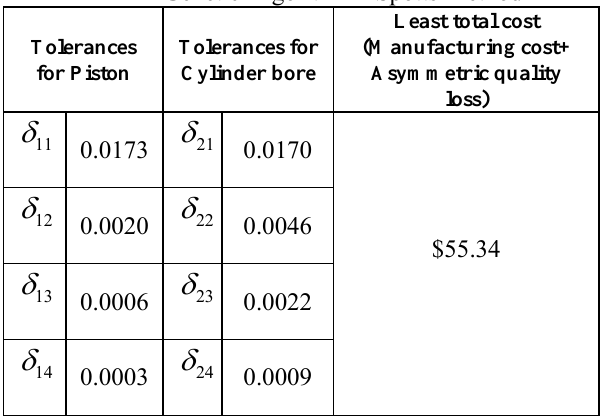
Table 5 Optimal tolerances allocated using